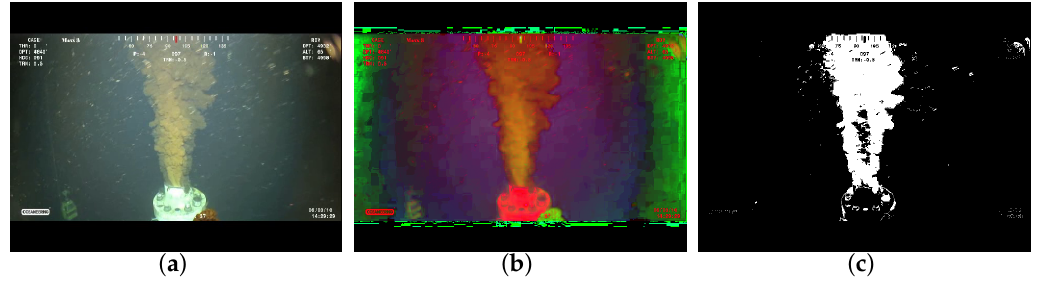
Figure 5. HSV threshold: ( a ) original image; ( b ) HSV image; and ( c ) color